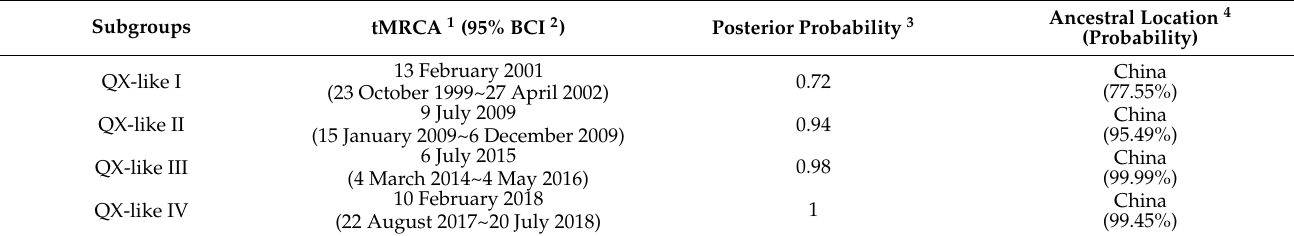
Table 2. tMRCA and posterior probability of the clades observed in the MCC tree of Figure